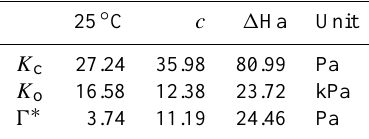
Table B1. The scaling constant ( c ) and energies of activation ( 1 Ha) describing the temperature responses for Rubisco enzyme kinetic parameters K c , K o and 0 ∗ . Taken from Bernacchi et al.